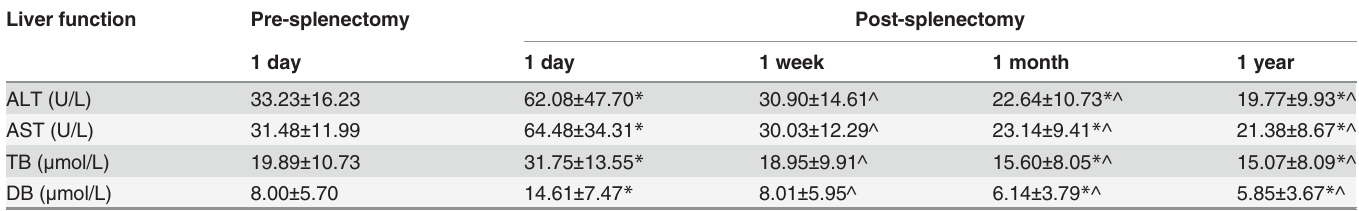
Table 4. Comparisons of liver function before and after splenectomy (mean ±